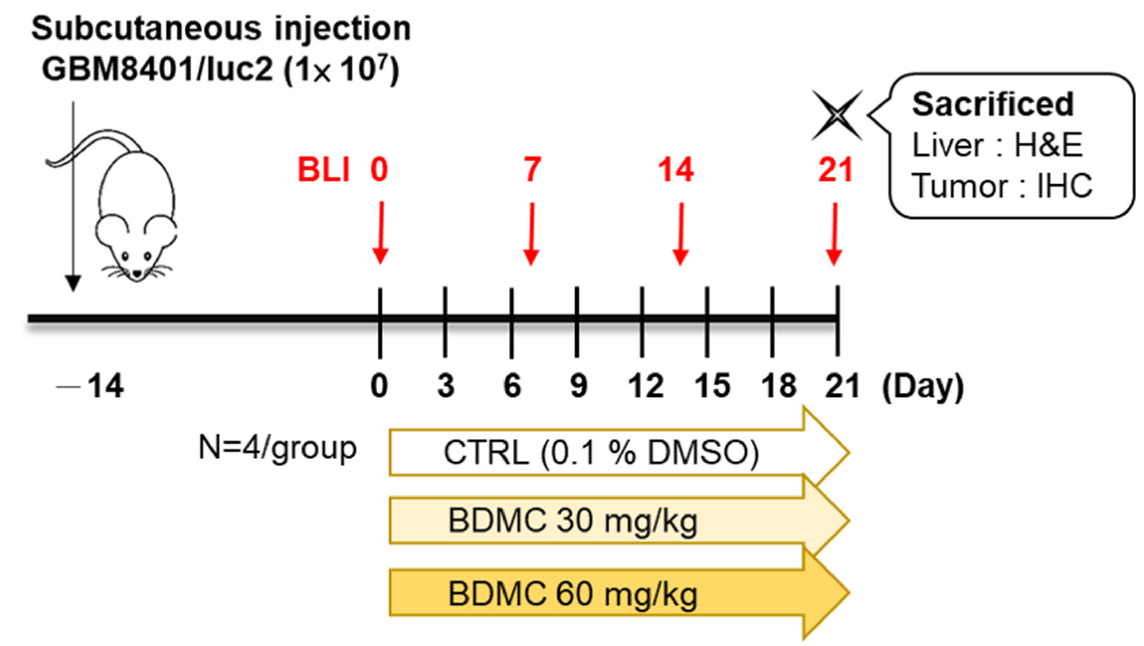
Figure 2. The flow chart for BDMC treatment in athymic BALB/c nu/nu nude mice after inoculation with GBM 8401/ luc2 cells. Twelve mice were inoculated subcutaneously with GBM 8401/ luc2 cells. Mice were randomly divided into three groups for treatment every day. Group I ( n = 4) was treated 0.1% DMSO in 100 µ L of DDW . Group II ( n = 4) was treated with BDMC (30 mg/kg). Group III ( n = 4) was treated with BDMC (60 mg/kg). Each mouse was treated by gavage for 21 days; the body weight and tumor size were recorded every 3 days, and bioluminescent imaging was performed every week, as described in the Materials and Methods.